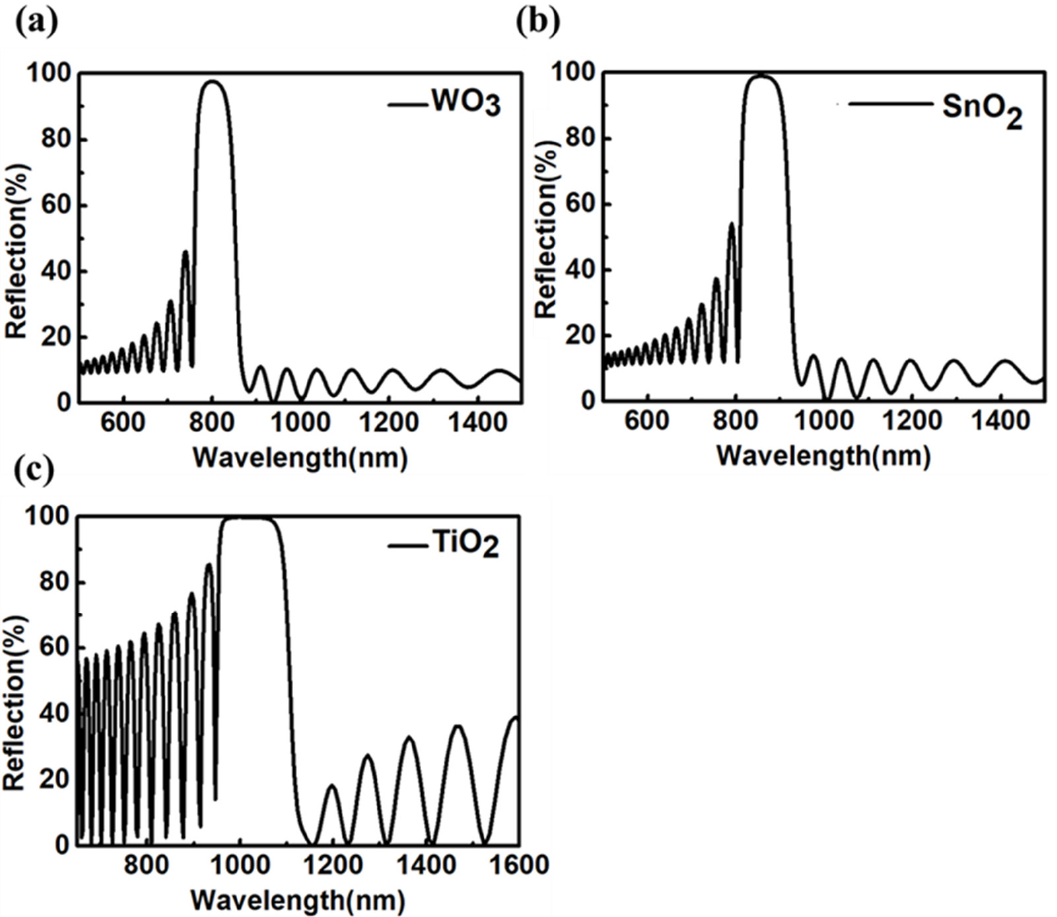
Figure 9. Simulation results of reflection spectra of IO structure systems after response to water, where the matrix materials of the systems are ( a ) WO 3 , ( b ) SnO 2 and ( c ) TiO 2 .